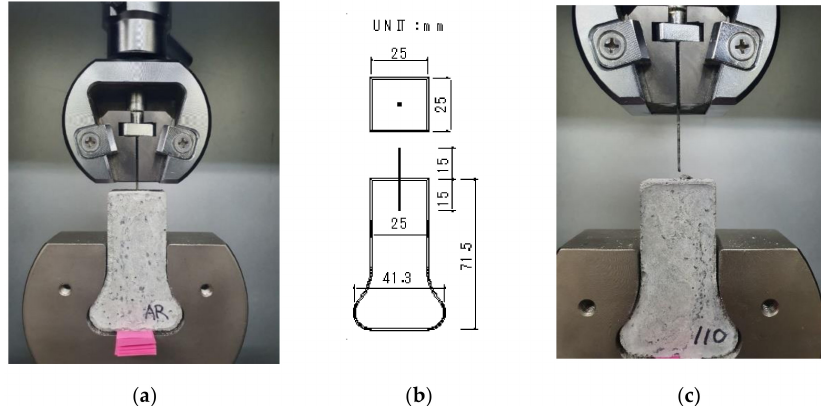
Figure 11. Test set-up and dimensions of a specimen: ( a ) test set-up; ( b ) dimensions of a specimen; and ( c ) photo of pulling out.